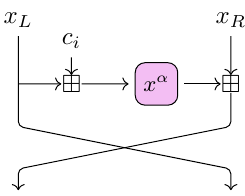
Figure 1: Round 𝑖 of